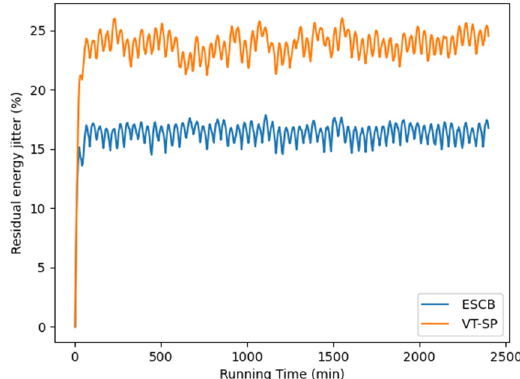
Figure 15. Average residual energy jitter.